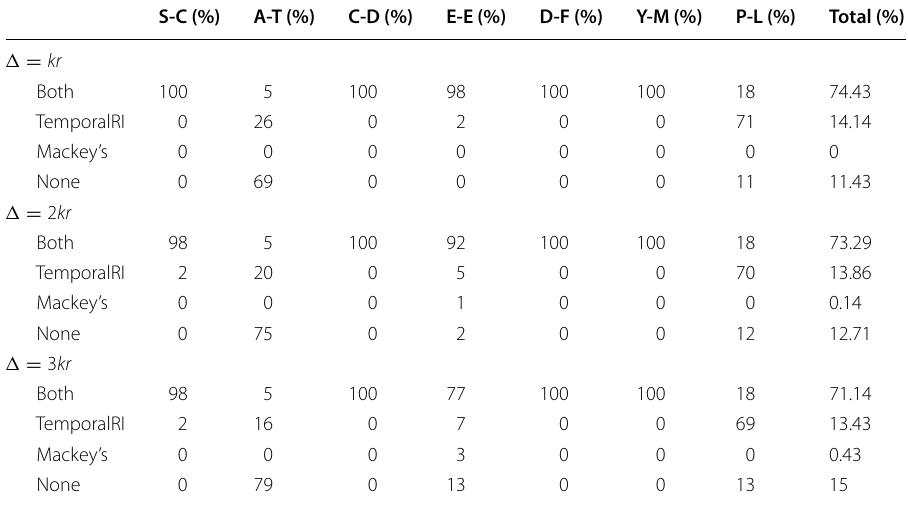
Table 3 Number of experiments with k = 6 completed by both algorithms, TemporalRI only, Mackey’s algorithm only and none of them